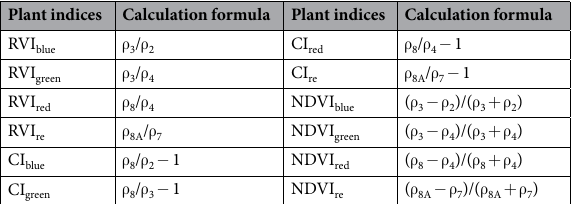
Table 2. The vegetation indices for monitoring of chlorophyll content. Note: ρ 2 , ρ 3 , ρ 4 , ρ 7 , ρ 8 , ρ 8A represent the surface reflectance of blue band 2, green band 3, red band 4, red edge band 7, band 8 and near-infrared band 8A,